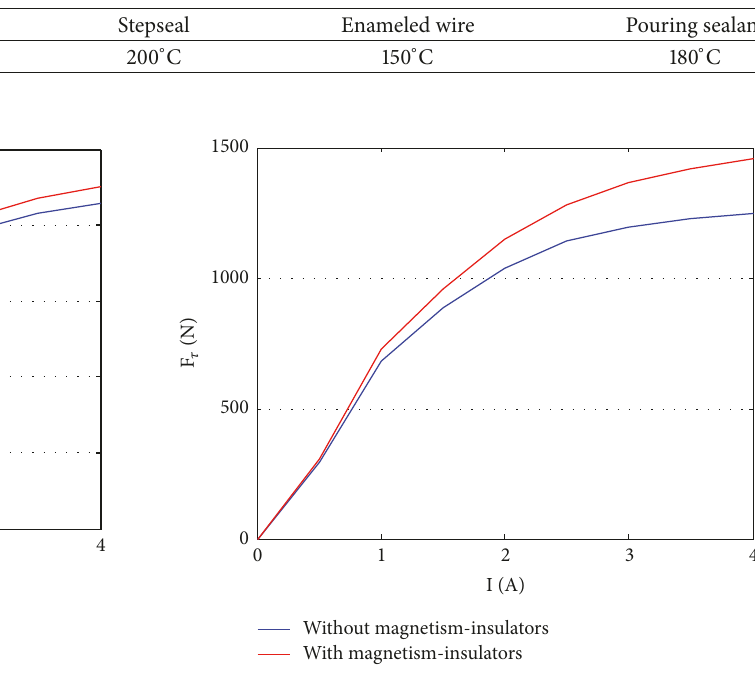
Table 3: Working temperature of the components.